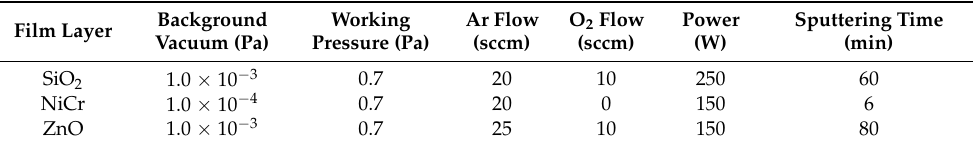
Table 2. Sputtering parameters of the thin films [41].